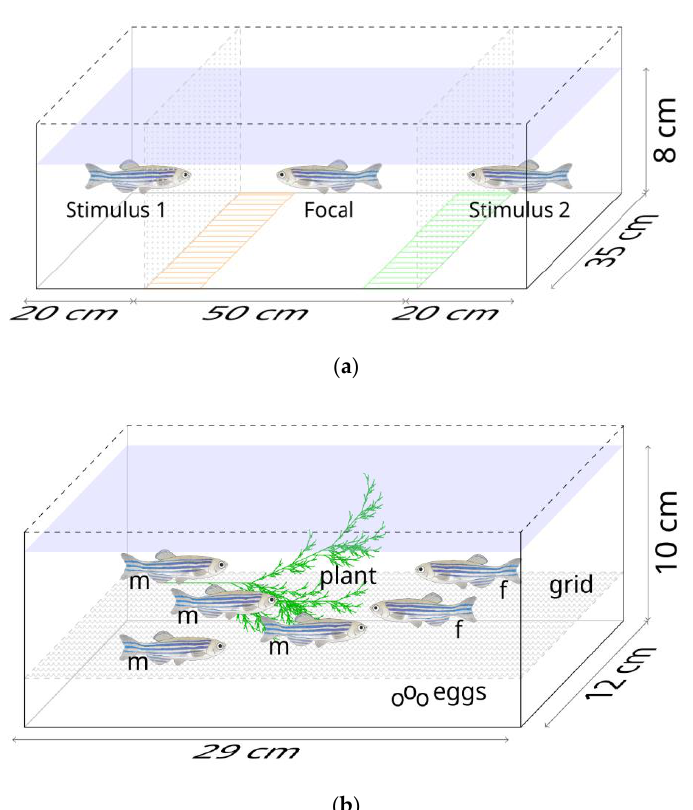
Figure 2. Diagrammatic representation of experimental setups for ( a ) prezygotic preference tests and ( b ) spawning trials. In the prezygotic setup, the orange and green areas represent preference zones. The postzygotic setup held two females “f” and four males “m”. The image of zebrafish used has been taken from the source https://commons.m.wiki-